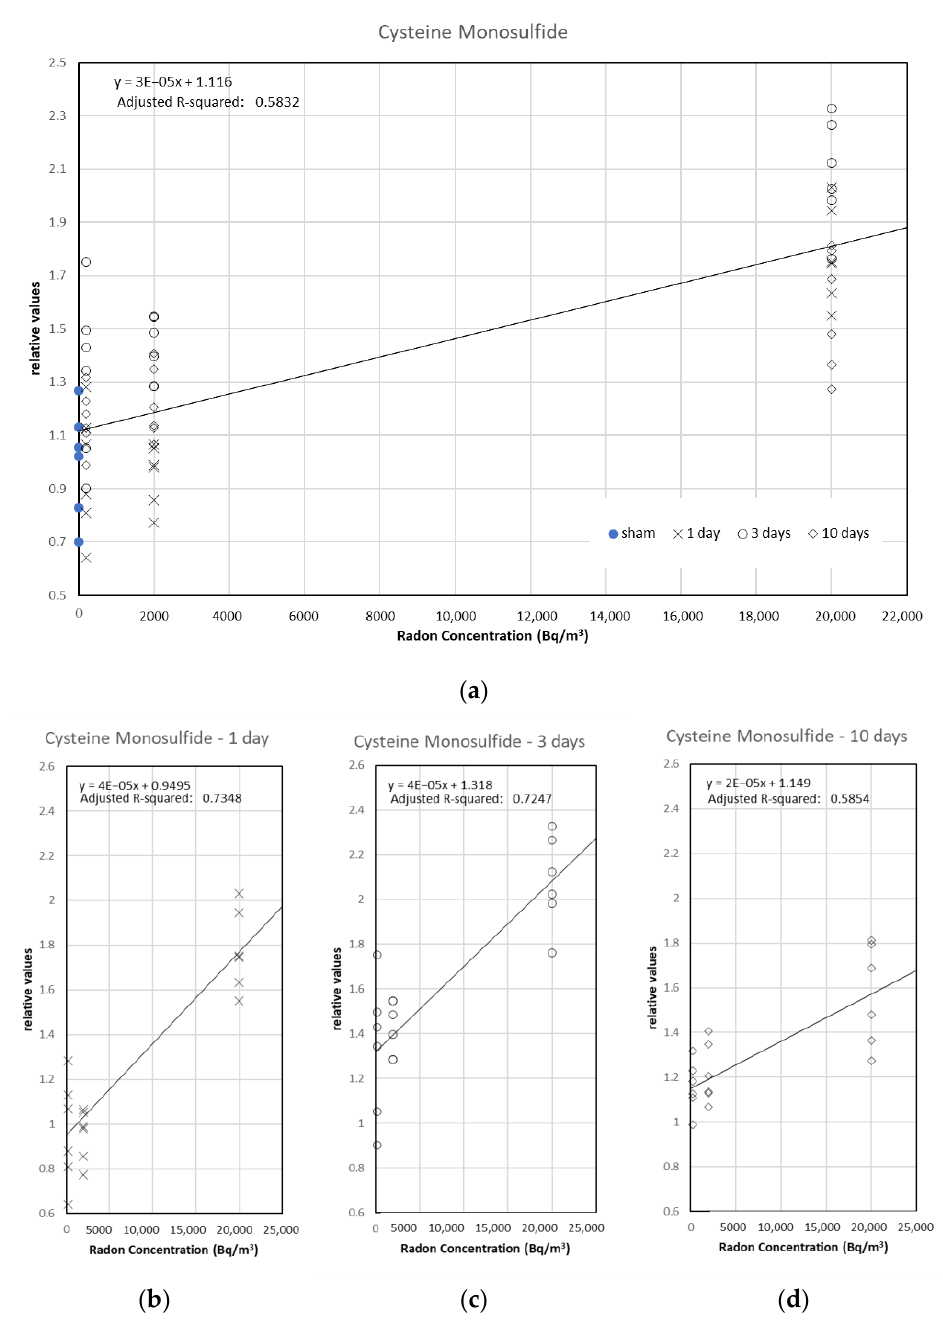
Figure 6. Scatter plots between radon concentration and Cys-S-SH with a simple linear regression. The results are shown for ( a ) all groups, ( b ) 1-day groups, ( c ) 3-day groups, and ( d ) 10-day groups.